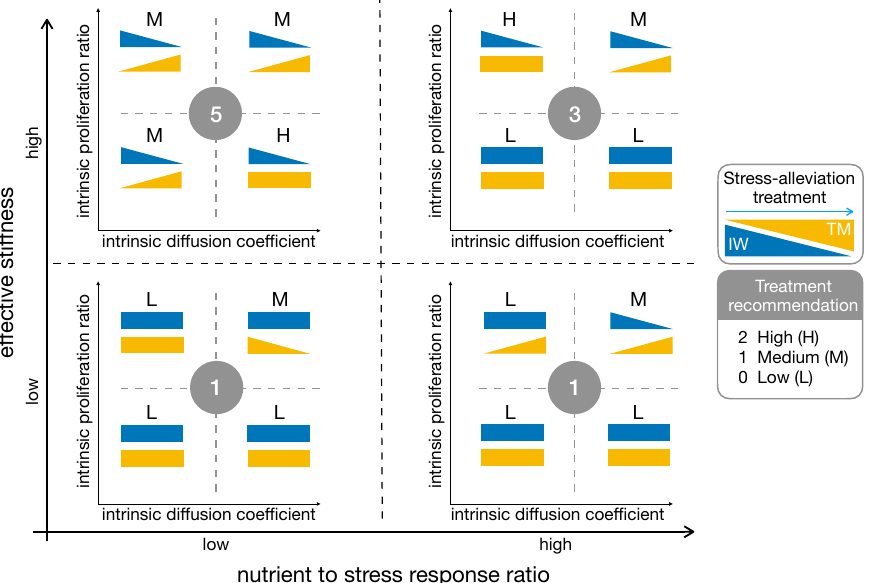
Figure 7. Summary of model results for chemo-mechanically induced phenotypic transitions. The triangles denote an increase (or decrease) of IW (blue) or TM (yellow) when a stress-alleviation treatment is performed. Rectangles denote a scarce effect of the treatment. The graph spans different levels of cell mechanosensitivity (vertical axis) and nutrient-to-mechanical response (horizontal axis). The labels and the circled numbers are related to the treatment recommendation score (L: